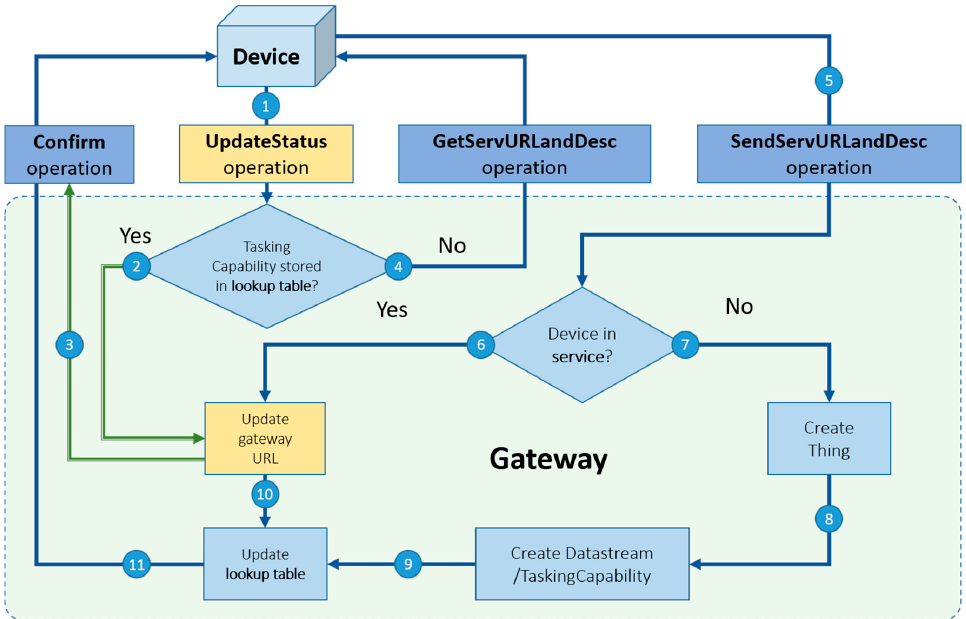
Figure 8. The workflow of the tasking capability registration procedure.